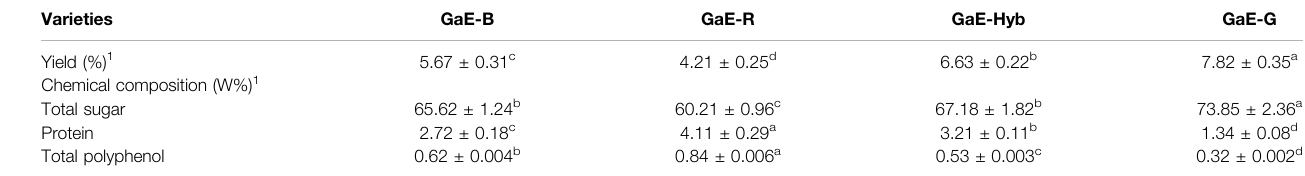
TABLE 1 | Yield and chemical compositions of four polysaccharides obtained by different varieties of Gastrodia elata . Varieties